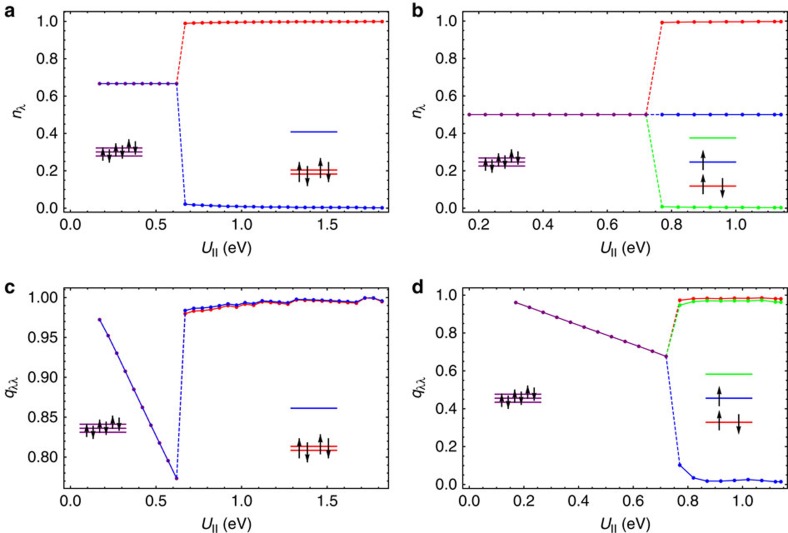
Occupation numbers and Gutzwiller reduction factors.(a) Occupation numbers per electron spin of LUMO orbitals nλ and (c) Gutzwiller reduction factors in the corresponding bands for a model A4C60 with cubic band dispersion (see the text) subject to static JT interaction as function of U||. (b,d) Same as a and c, respectively, for fcc A3C60.